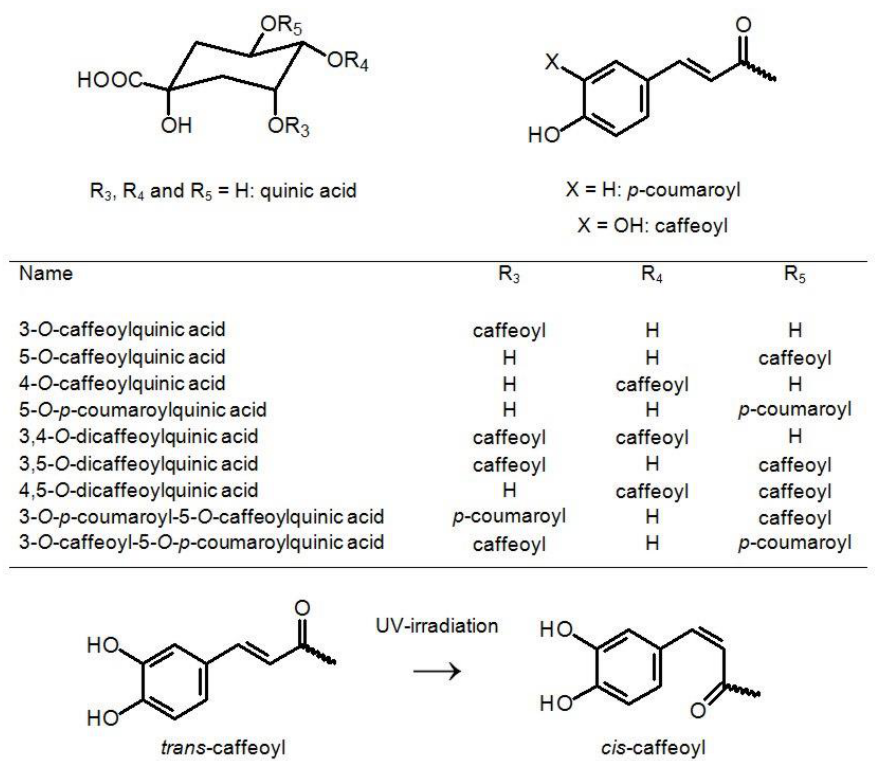
Figure 4. Structures of caffeoylquinic acids found in S. radiate plants and calluses. A scheme explaining geometric isomerization of caffeoyl moieties under UV irradiation is presented.